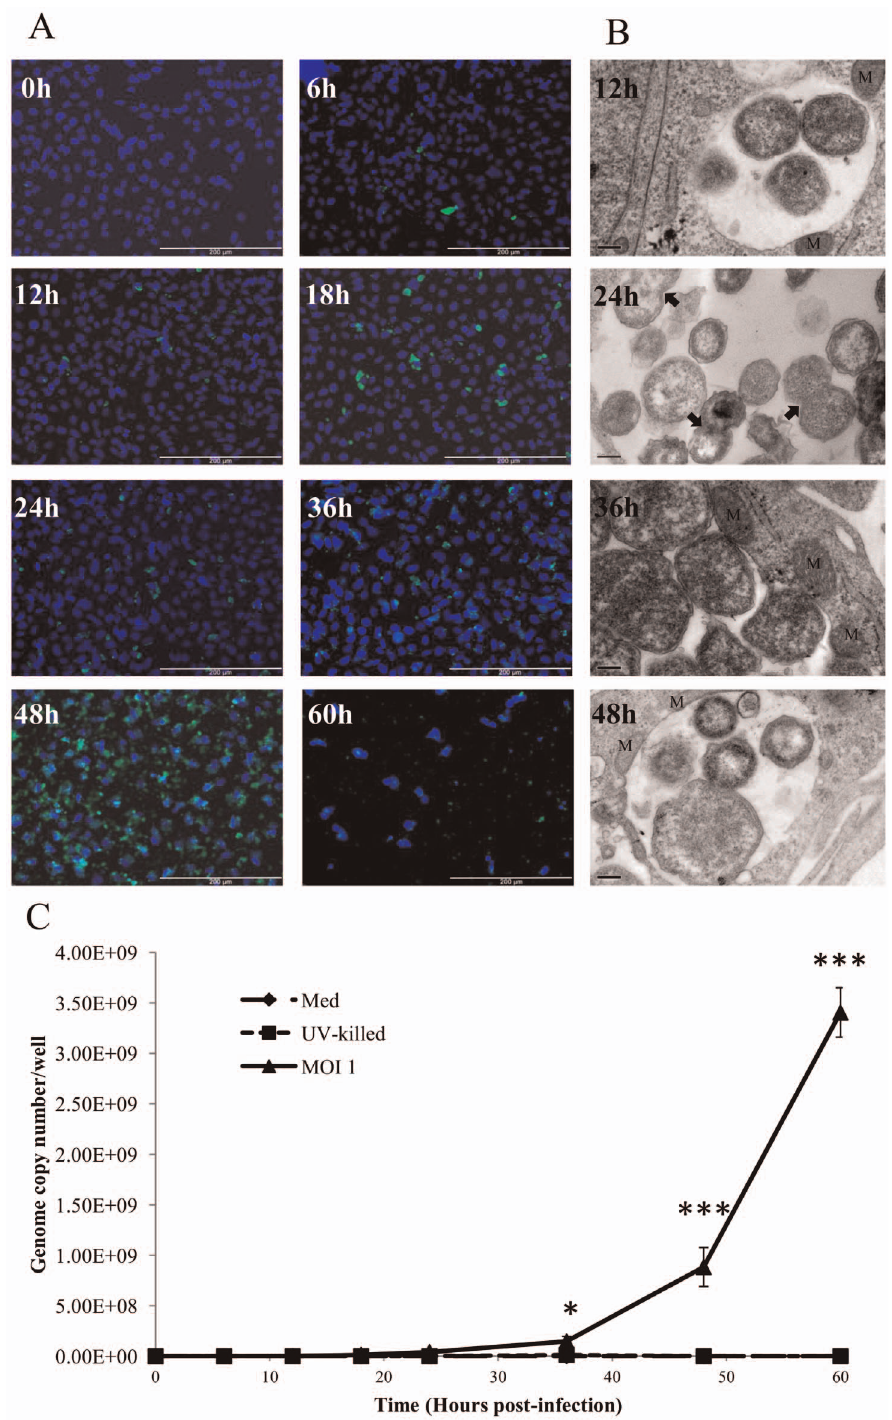
Figure 2. Bacterial growth within AH-1 trophoblast cells. A) Growth of W. chondrophila in AH-1 cells assessed by fluorescence microscopy. W. chondrophila inclusions are labelled green using an anti- Waddlia rabbit polyclonal antisera and FITC anti-rabbit secondary antibody, host cell nuclei are stained blue (Dapi). The scale bars correspond to 200 m m. B) Transmission electron micrographs at various specified time-points post-infection, demonstrating RB dividing by binary fission (24 h panel indicated by the arrows) and mitochondria associated with the inclusion (12 h, 36 h and 48 h panels indicated by M) and multiple forms of the organism (48 h panel) as the RBs condense to EBs. C) Quantitation of W. chondrophila growth by qPCR for 60 h post-infection. AH-1 cells were exposed to live W. chondrophila (MOI 1), UV- killed organisms (UV-killed) or medium alone (Med) and DNA isolated at the indicated time-points over the 60 h time-course. Statistically-significant differences relative to initial genome copy numbers at 0 h post-infection are indicated by *P , 0.05; ***P , 0.001 Data were analysed by two-way ANOVA. Comparisons between individual treatments were made using Tukey’s multiple comparison test (n=3).